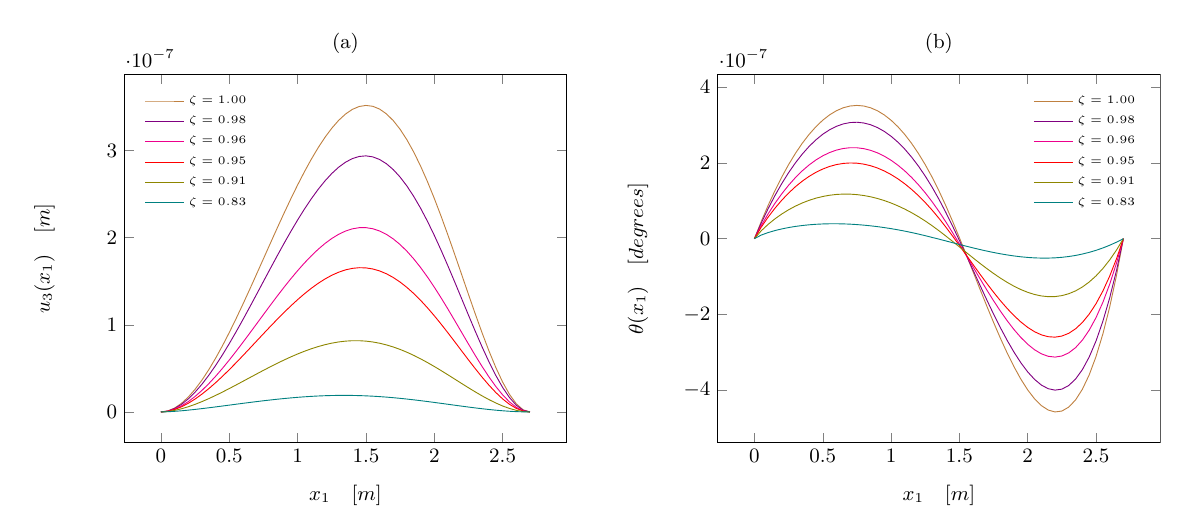
Figure 5. Simply supported beam: ( a ) lateral displacement and ( b ) rotation.